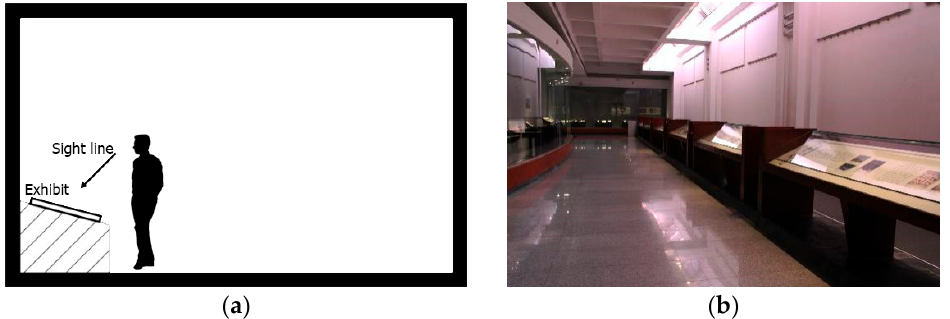
Figure 3. Slanted display ( a ) Schematic diagram of exhibit arrangement; ( b ) Example: Guangzhou Museum of Art.